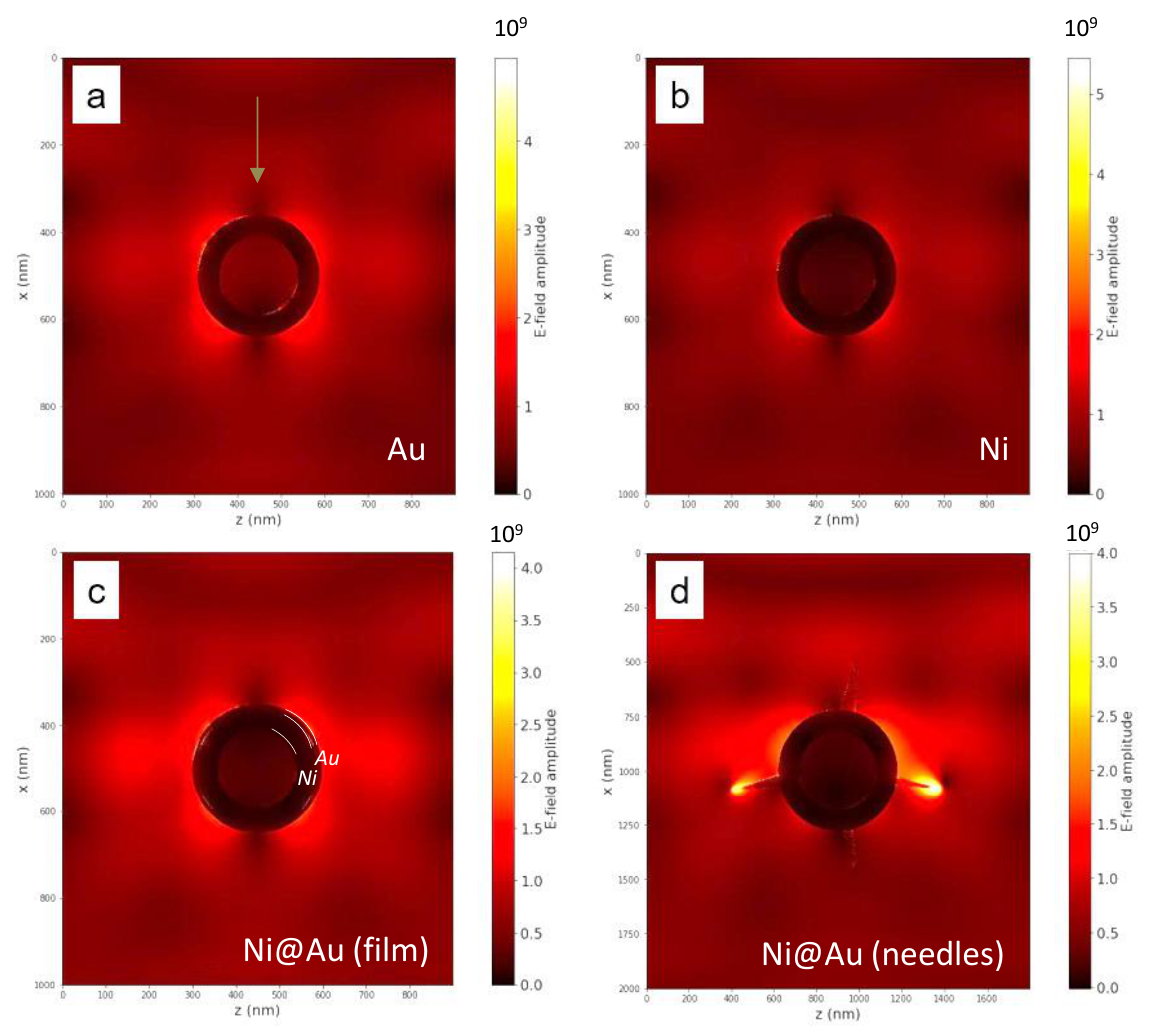
Figure 2. Electric field distribution around Ni/Au nanostructures. ( a ) Nanotubes made of pure gold, ( b ) nanotubes made of pure nickel, ( c ) core/shell (nickel/gold) nanotubes with a smooth Au layer, ( d ) Ni nanotubes covered by a uniform layer of Au needles. The exiting radiation wave- length was 532 nm.